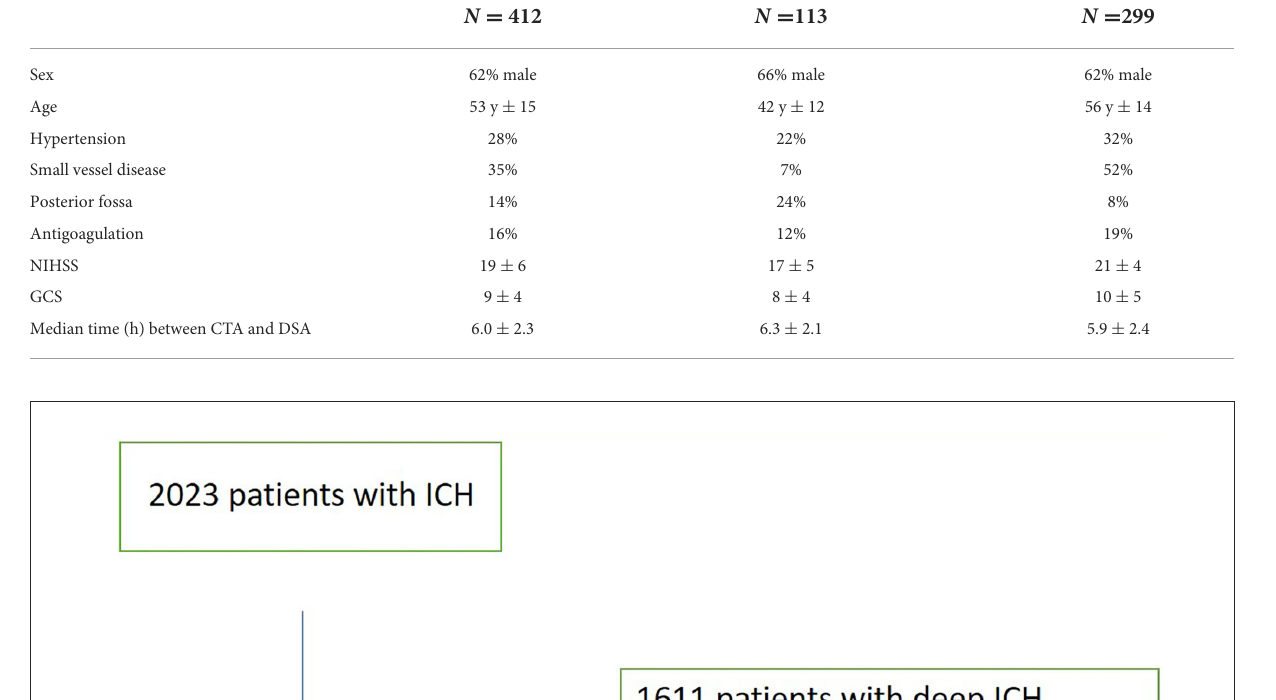
FIGURE1 Inclusion flow chart.